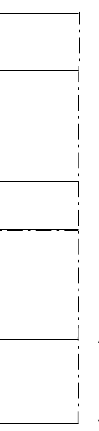
Figure 17: Scheme of the column cross-section center of gravity detection